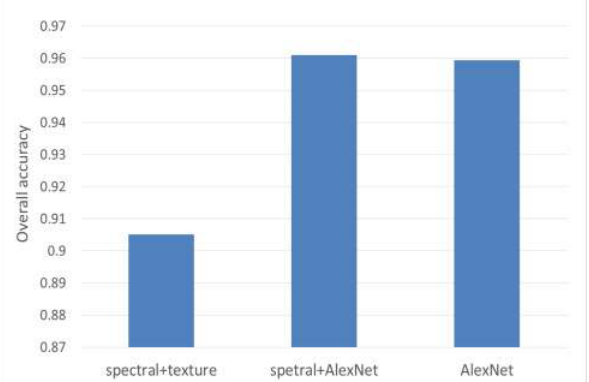
Figure 5. The accuracy comparison chart by different